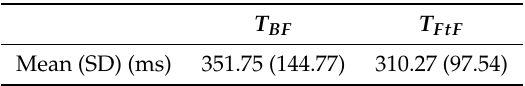
Table 1. Evaluation of response time: the standard deviations (SDs) of the device’s response times to physically being faced state ( T BF ) and face-to-face state ( T FtF ) of the test head.